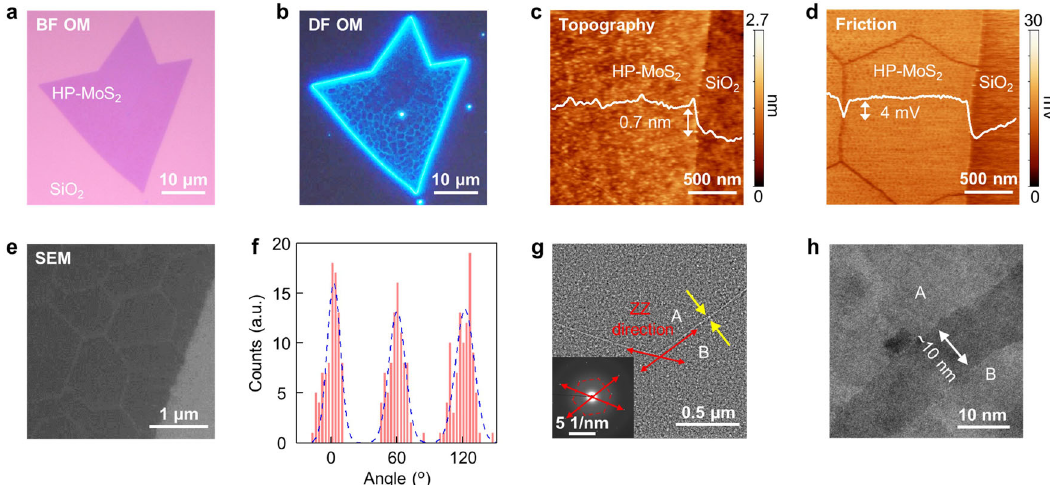
Fig. 4 Microscopic observation of nanocracks in HP-MoS 2 (30 min). Bright ( a ) and dark ( b ) fi eld optical microscopic image, SEM image ( c ), topography ( d ), and friction map ( e ) obtained from HP-MoS 2 (30 min), respectively. f Histogram of angle difference between lines and edge of the crystal. g TEM images obtained from the cracked region. Yellow arrows indicate the location of the crack between ‘ A ’ and ‘ B ’ , and red arrows indicate the zigzag (ZZ) lattice directions of HP-MoS 2 . Inset shows SAED patterns achieved from a region containing both ‘ A ’ and ‘ B ’ . h STEM image obtained nearby linear region, showing ~10 nm of gap between two